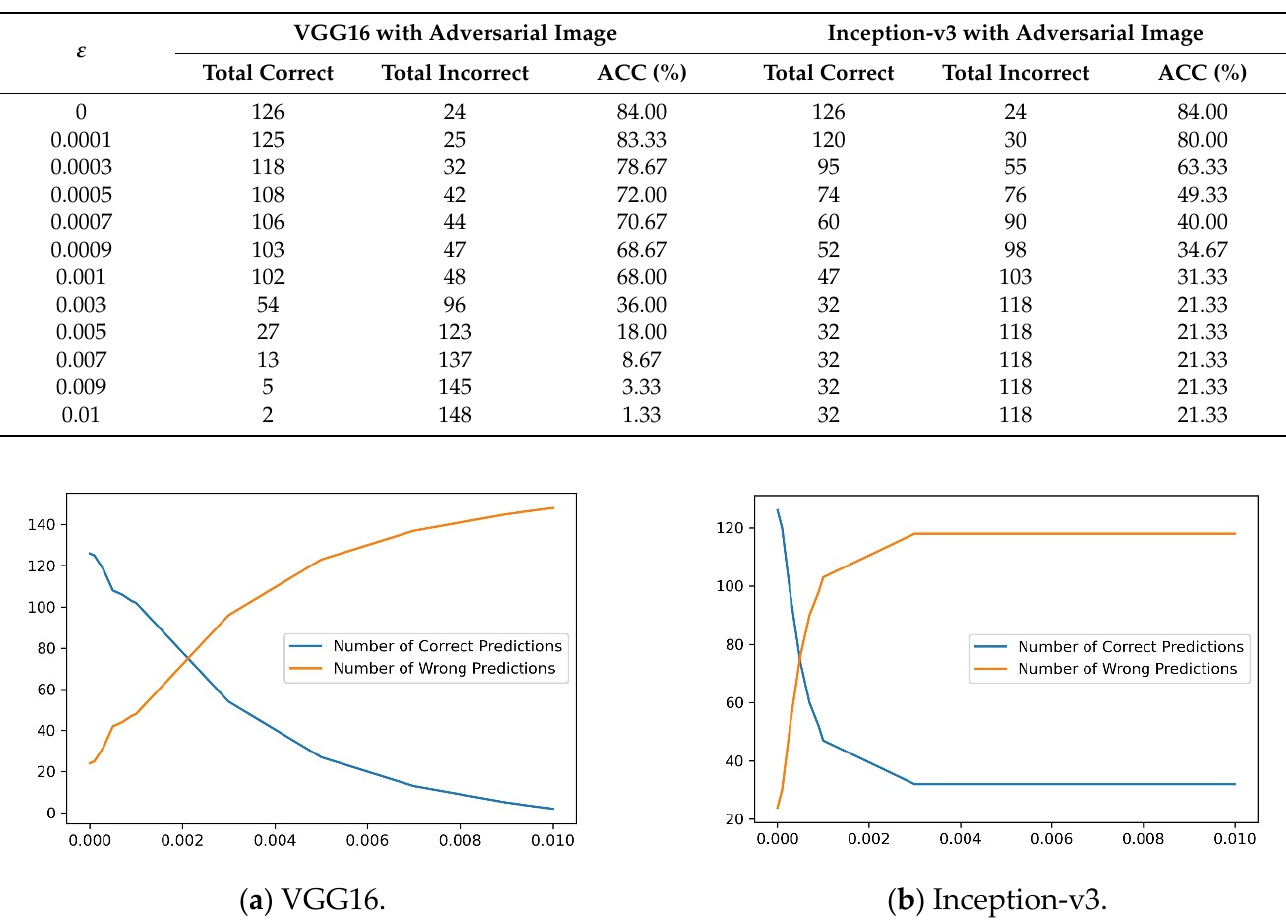
Figure 12. Performance for different ε of FGSM attack in chest CT images. Finally, we investigated the drop in class probability score for correctly classified CT images based COVID-19 detection. Figure 13 shows that for same image, FGSM attack resulted in a decrease in probability score for the image to belong to any class. As shown in Figure 13, for a ε of 0.009, the probability of a COVID-19-positive image belonging to COVID-19-positive decreases to 0.93 from that of 0.99 when VGG16 is used. The probability also decreases to 0.98 from that of 1.00 for the Inception-v3 network in the presence